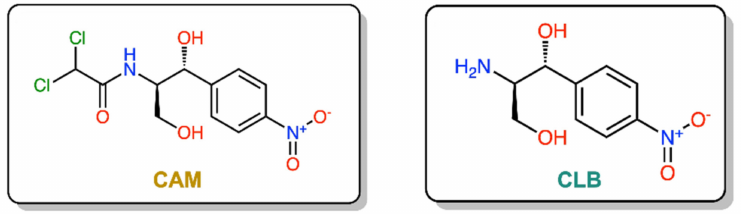
Figure 1. Structures of chloramphenicol (CAM) and chloramphenicol base